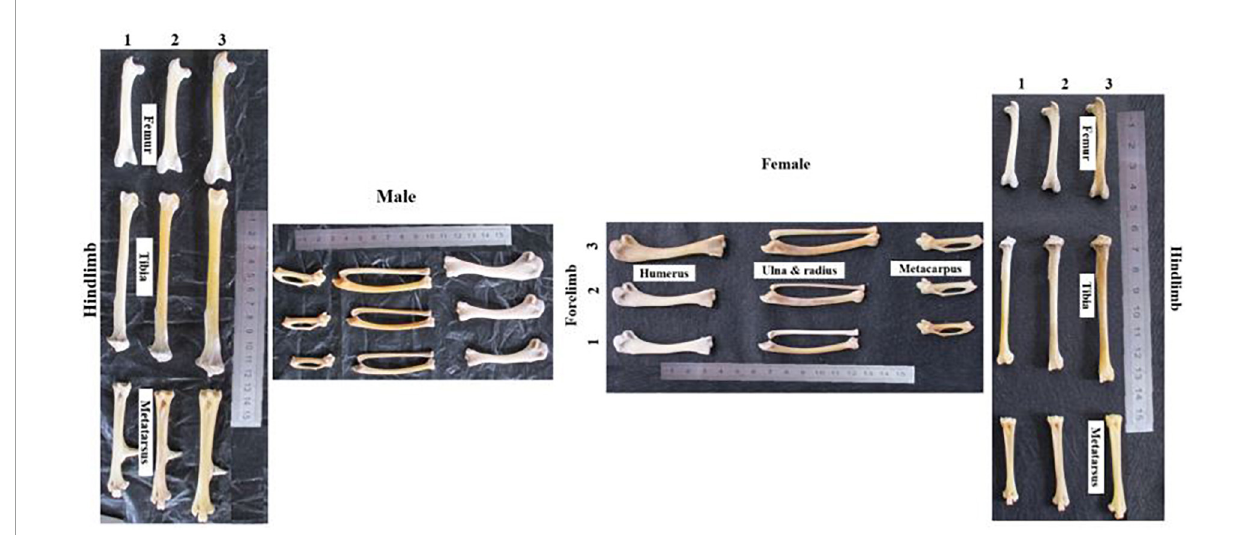
FIGURE4 Osteology picture of male and female chicken across the three agroecologies. 1, highland; 2, midland; and 3, lowland.